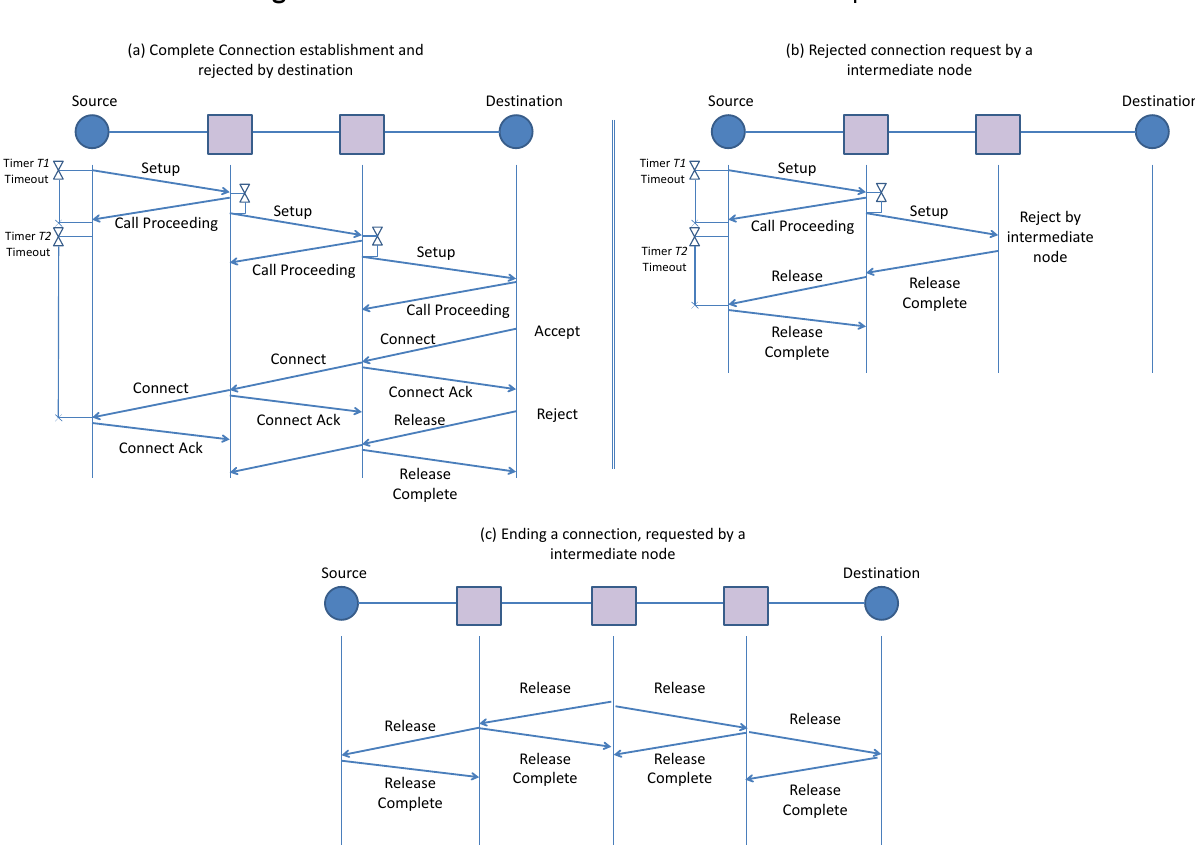
Figure 10. Overview of connection establishment